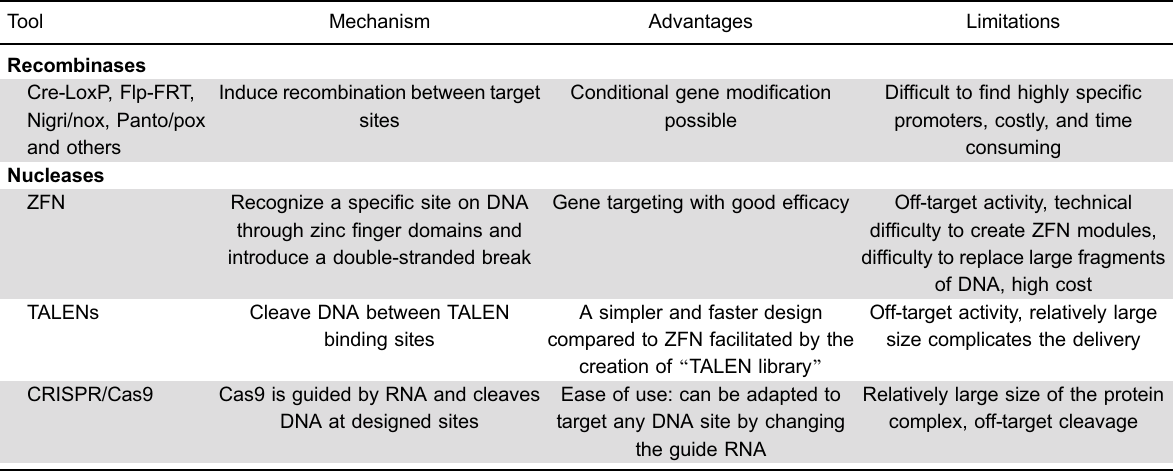
Table 1. Brief characteristics of available molecular gene editing